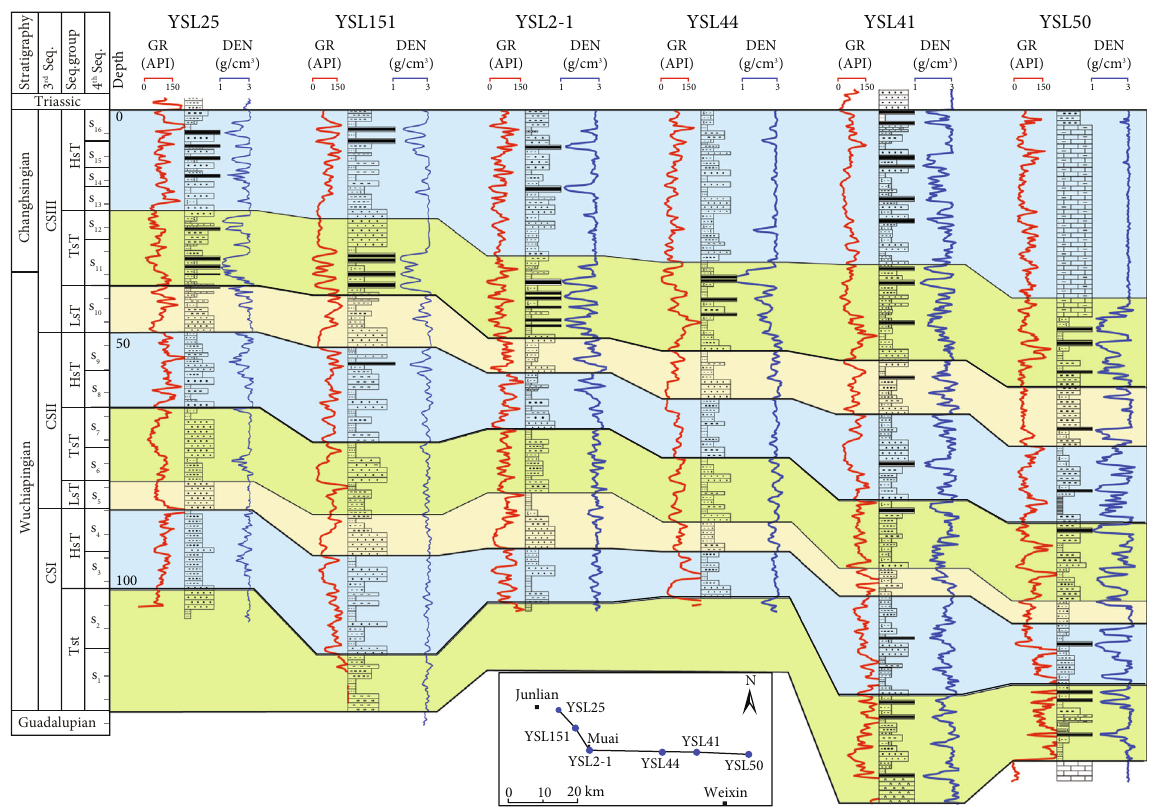
Figure 4: Stratigraphic framework of the Lopingian stratigraphy in the Junlian of southern